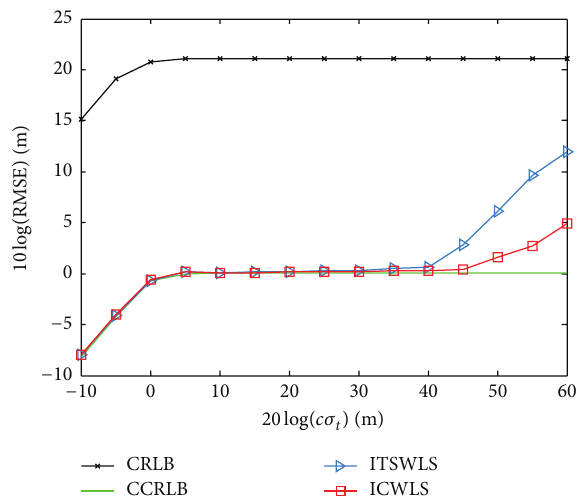
Figure 2: Comparison of target geolocation RMSEs of ITSWLS and ICWLS as a function of 𝑐𝜎 𝑡 .